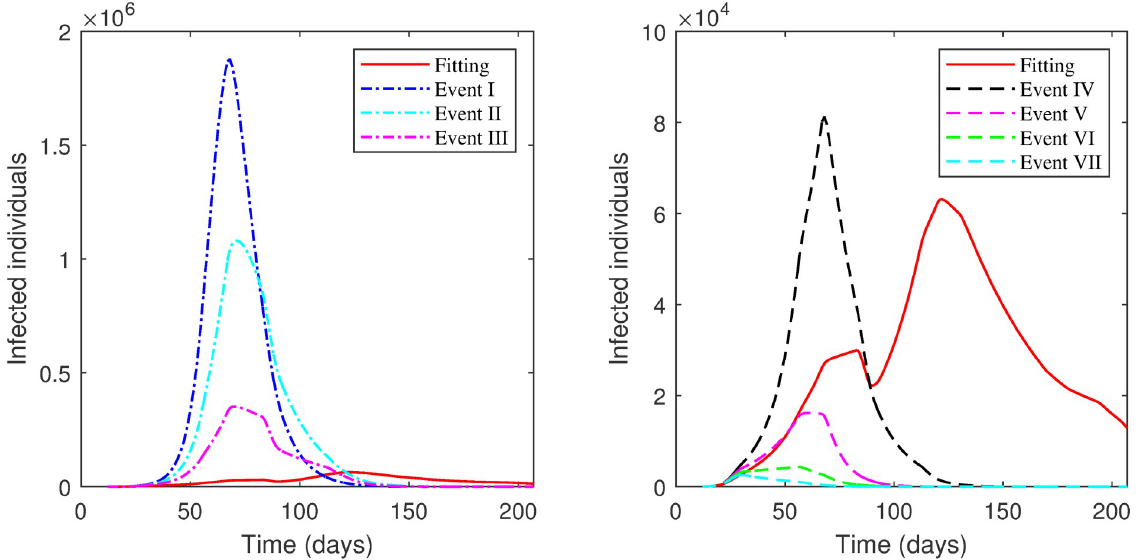
Fig 13. Numerical solution of model (1) for infected compartment vs. time for 1 st scenario of Second Case.